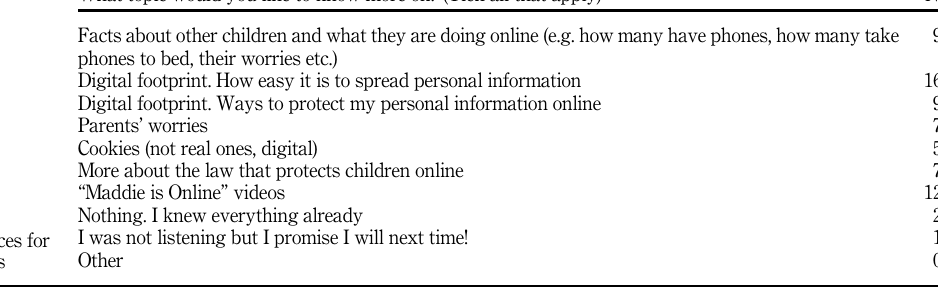
Table 1. Topic preferences for future activities